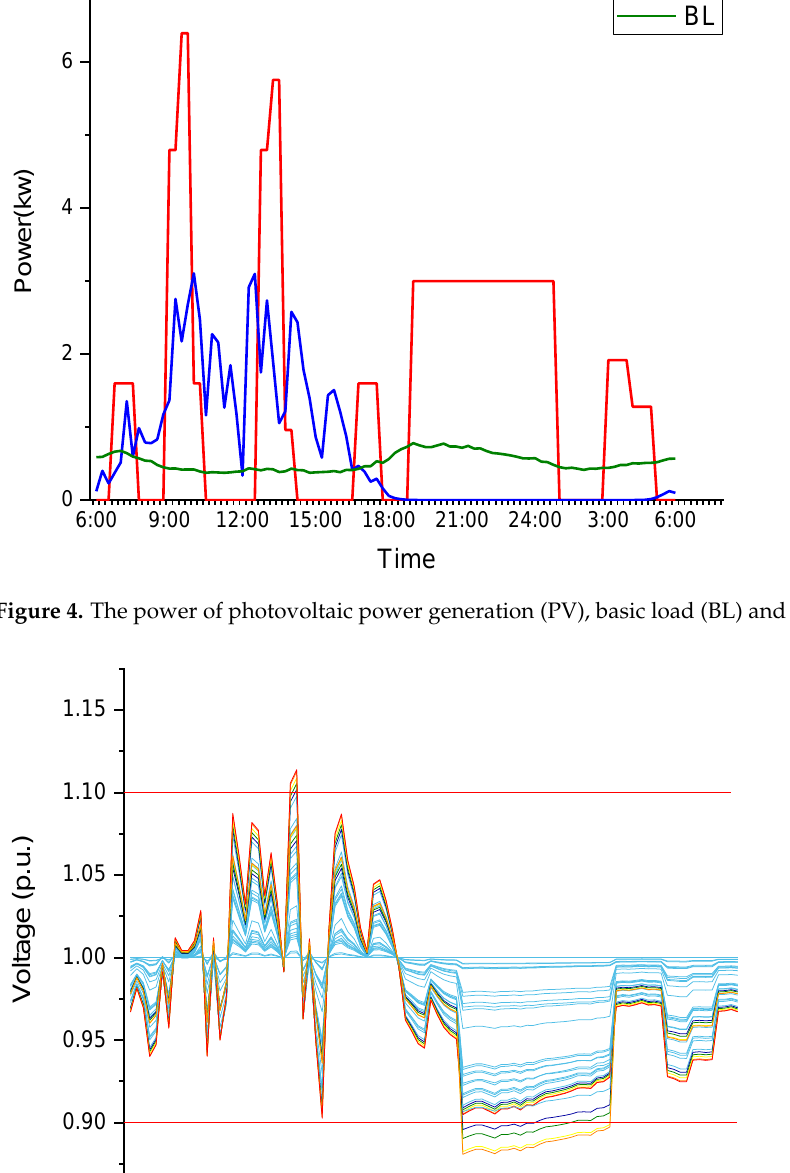
Figure 4. The power of photovoltaic power generation (PV), basic load (BL) and flexible load (FL).